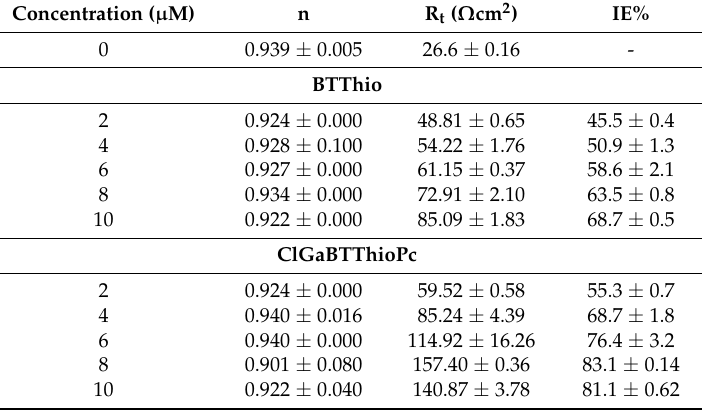
Table 3. Parameters from EIS data fitting for aluminium in 1.0 M hydrochloric acid in the absence and presence of inhibitors.